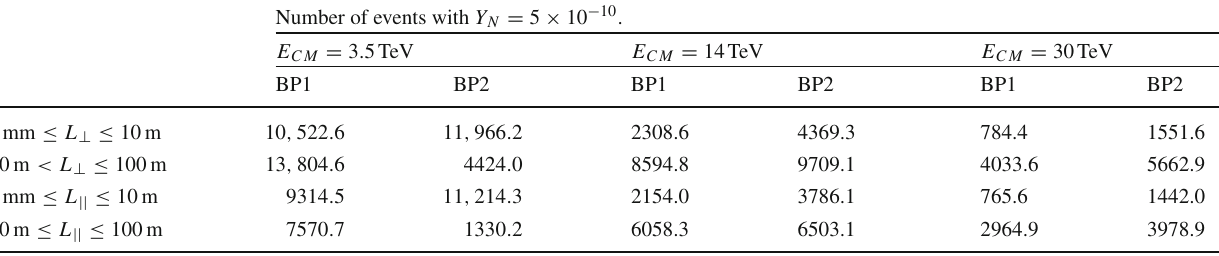
Table13 Thenumberofeventswithintherange1mm–10m and10m– 100m in the transverse ( L ⊥ ) and longitudinal ( L (cid:12) ) direction for the benchmark points at the centre of mass energies of 3.5, 14 and 30TeV